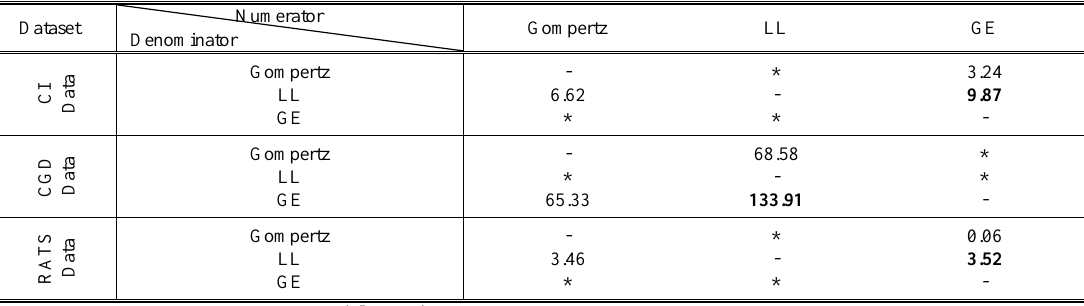
Table 5. 2 logBF 10 values for comparing M 1 / M